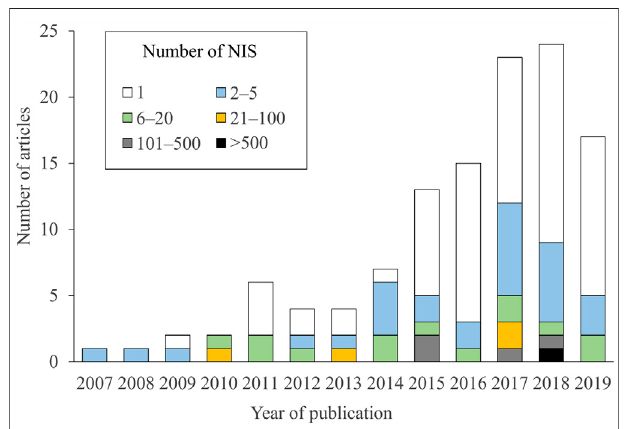
FIGURE 1 | Number of articles published on citizen science and non- indigenous species (NIS) since 2007. The number of species studied in each article is also shown and divided into six categories. A total of 126 studies reported information with this issue. Data were retrieved from a bibliographic survey made in July 2019 with SCOPUS using a combination of keywords: “ invasive species ” and “ citizen science ” , “ non-indigenous species ” and “ citizen science ” , and “ non-native species ” and “ citizen science ”